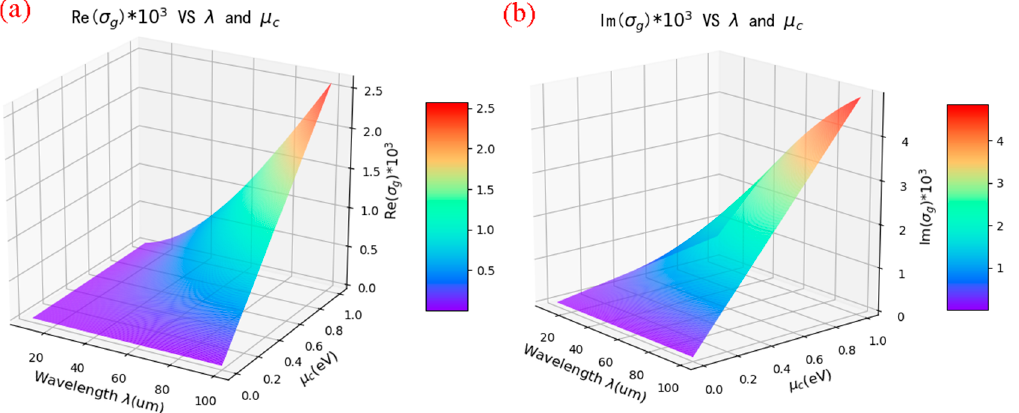
μ and λ . σ as functions of c g